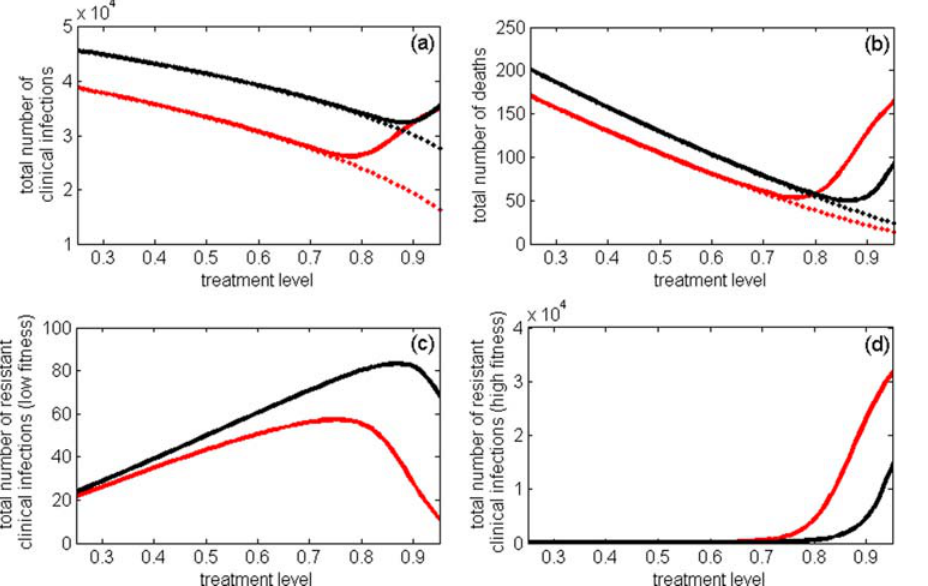
Figure 3. (a) Total number ofclinical infectionscaused by the wild-type, low fitness resistant, and highfitness resistant strains;(b) Totalnumber of deaths; (c) Total number of clinical infections caused by the low fitness resistant strains; (d) Total number of clinical infections caused by the high fitness resistant strains, as a function of treatment level. Treatment of infected individuals begins one day after the onset of clinical disease; red and black curves correspond, respectively, to the reproduction numbers R w correspond to the scenario in which no compensatory mutations occur, and resistant mutants are only present at low fitness cost. doi:10.1371/journal.pone.0001839.g003 PLoS ONE |